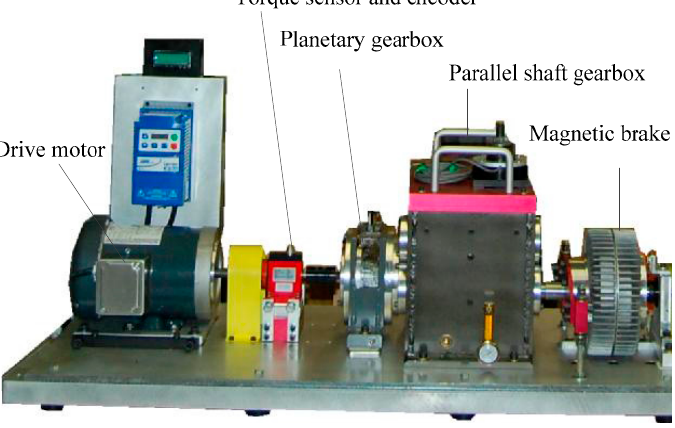
Figure 17. Experimental test rig.